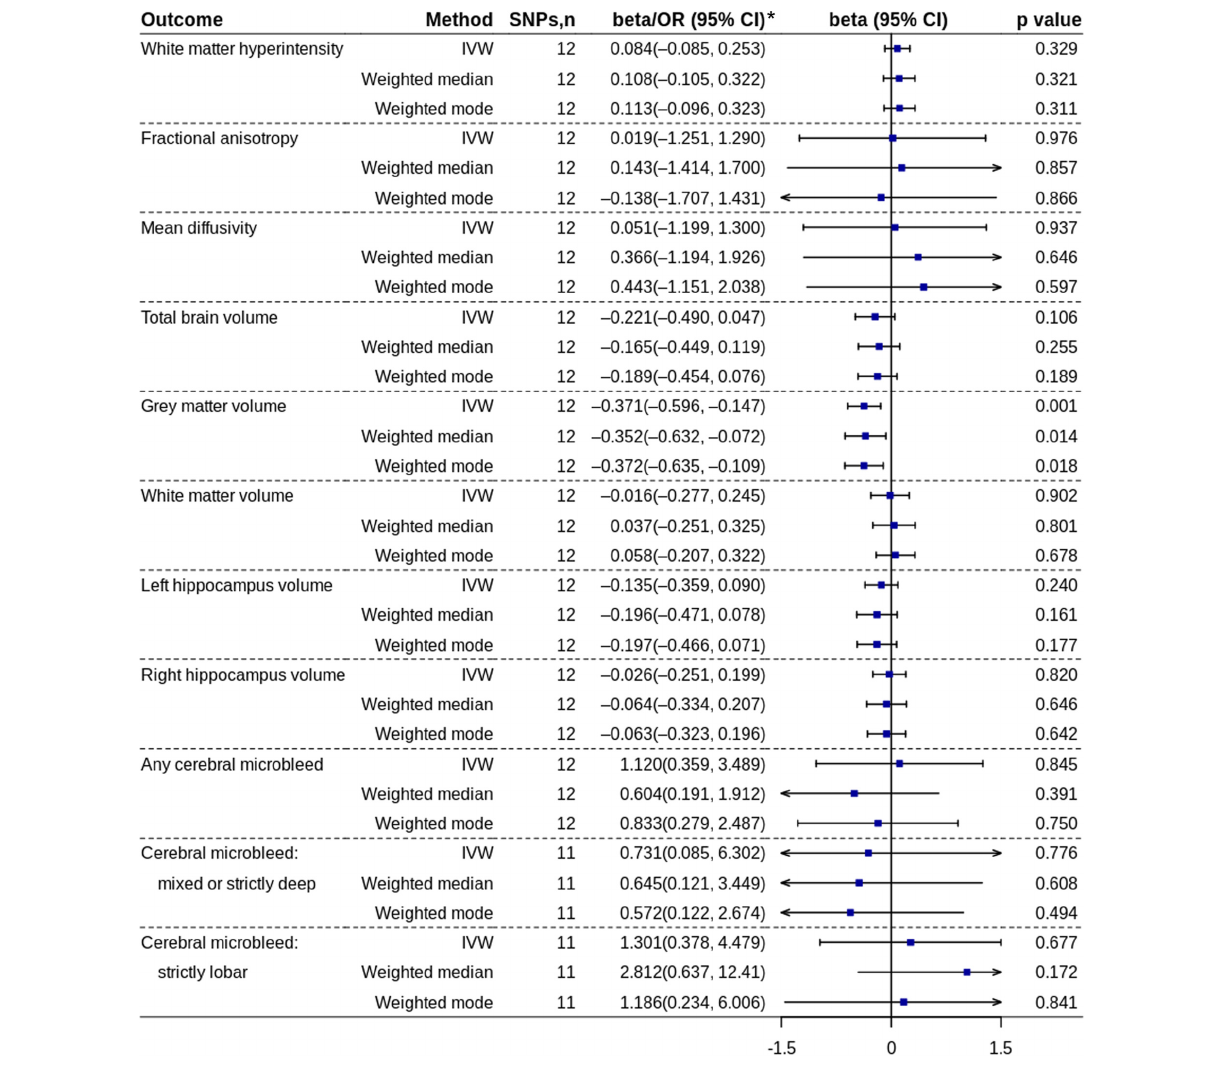
Frontiers in Nutrition |